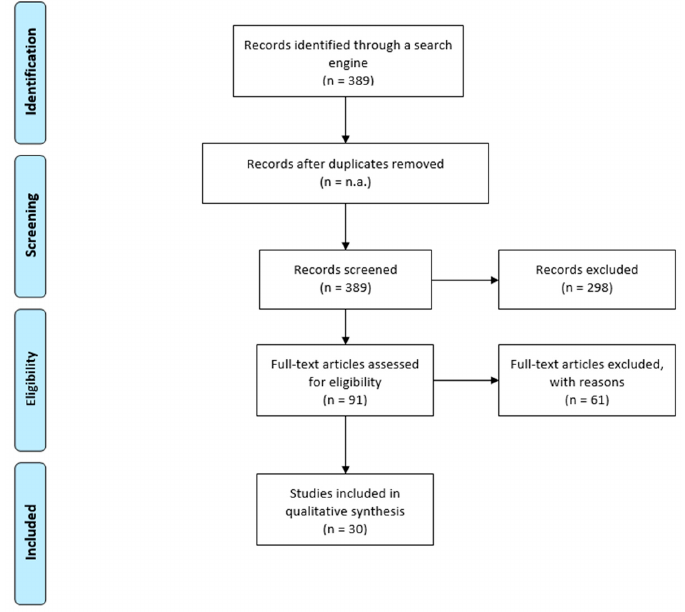
Figure 1. PRISMA flow diagram of the literature review on the police patrol routing problem.